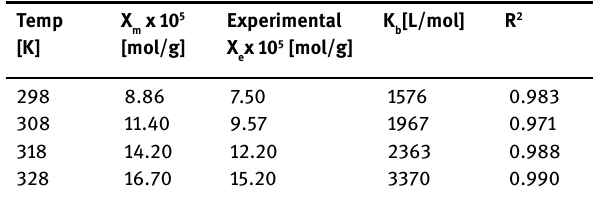
Table 1: Langmuir parameters for Cr (VI) adsorption on micro-powder